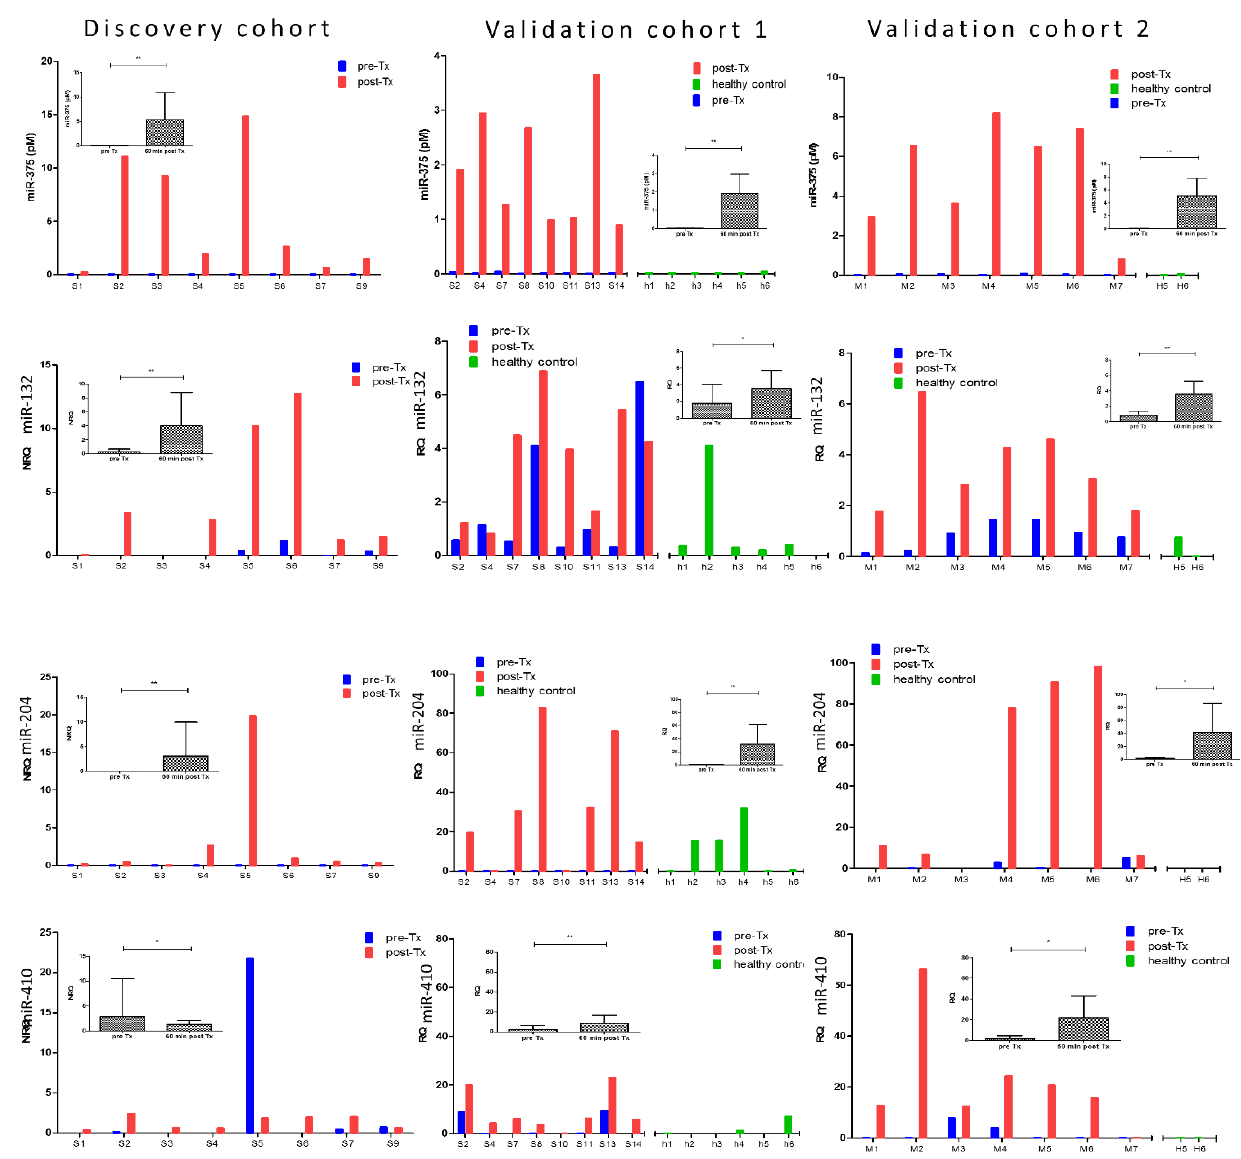
Figure 4. microRNA levels before and 1 h after islet transplantation in three independent cohorts of 4 microRNAs with the strongest islet endocrine enrichment. From top to bottom, panels show the NRQ microRNA levels in individual samples the discovery cohort ( n = 8 transplants, Brussels) and RQ microRNA levels in validation cohort 1 ( n = 8 transplants and n = 6 healthy controls h1-h6, Brussels) and validation cohort 2 ( n = 7 transplants and n = 2 healthy controls, H5-H6, Milan). Average ± SD and p value (* p < 0.05; ** p < 0.001, paired student- t test) in inset. Bar colors indicate pre-transplant (pre-Tx, blue), 1 h post-transplant (post-Tx, red) or healthy control (green).